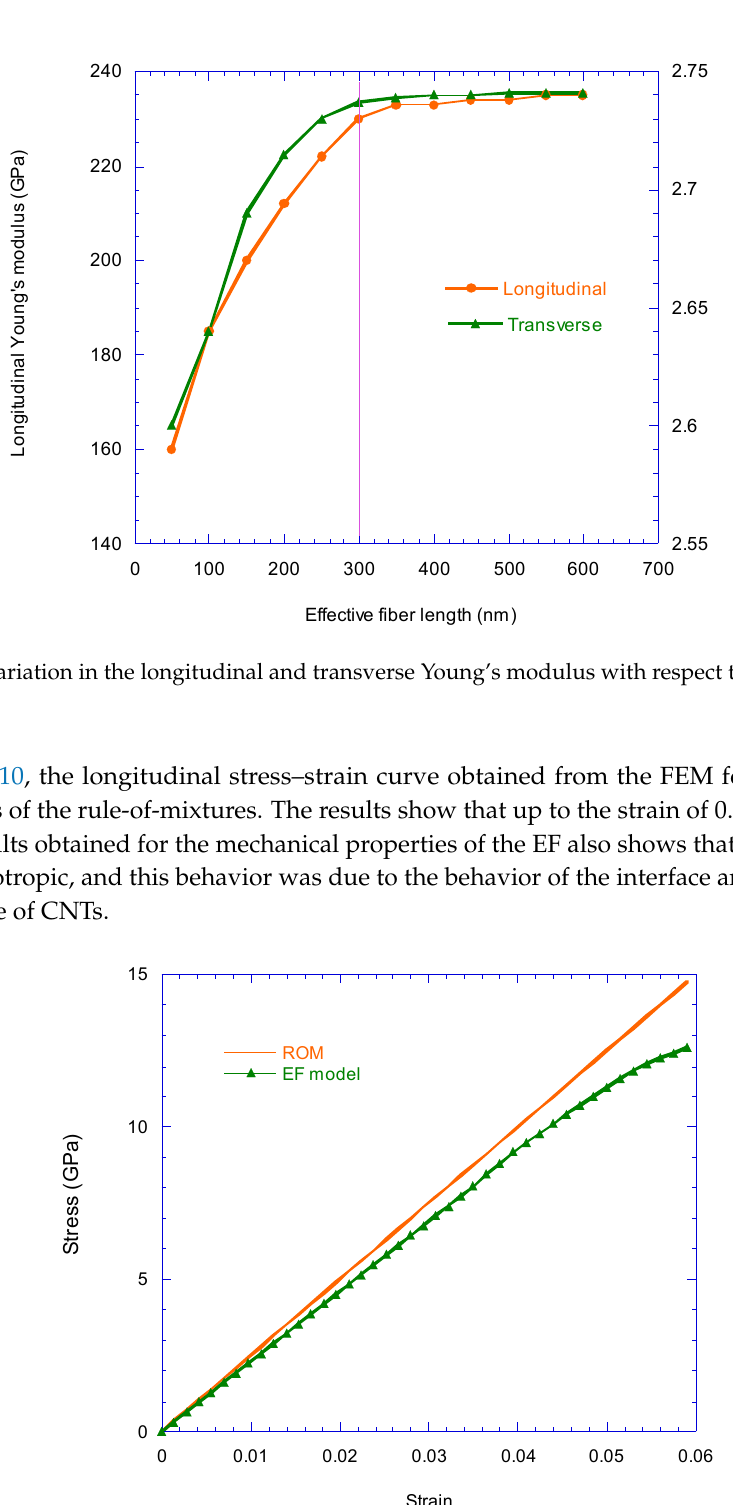
Figure 10. Comparison of longitudinal stress–strain behavior of the finite element analysis EF model and the rule-of-mixtures (ROM).